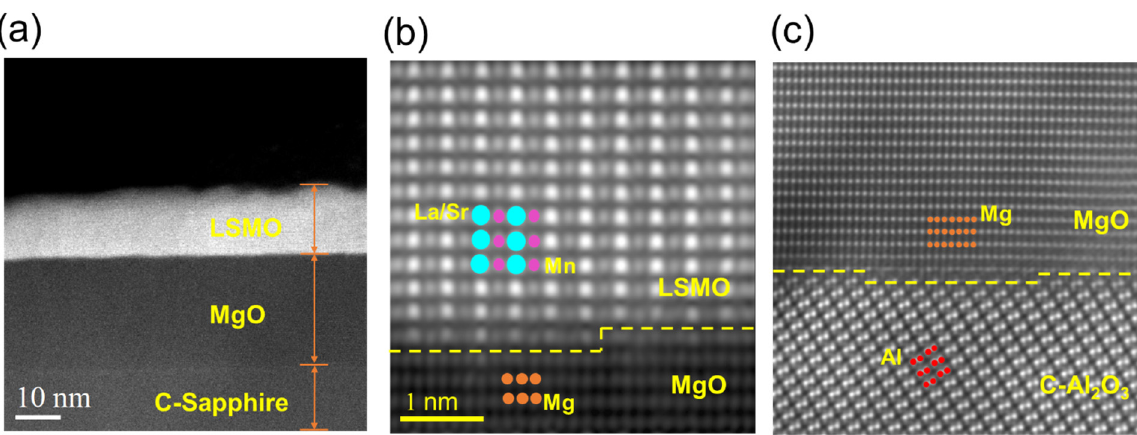
Figure 1. ( a ) A representative HAADF image of LSMO thin film grown on the c-Al 2 O 3 substrate where MgO is the buffer layer. Atomic resolution HAADF image showing the interface between the ( b ) LSMO thin film and the MgO buffer layer, ( c ) the MgO buffer layer, and c-Al 2 O 3 substrate.